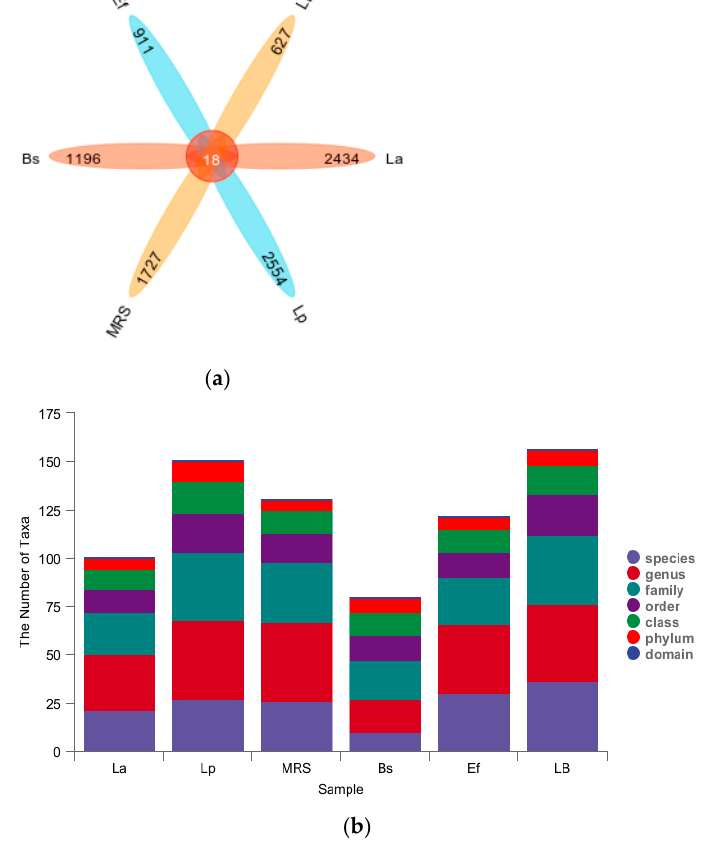
Figure 2. Classi fi cation unit number statistics: ( a ) petal map of taxonomic unit statistics (indicating the number of OTUs unique and common to each of the six groups Lp, La, MRS, Bs, Ef, and LB); ( b ) histogram of taxonomic unit statistics (indicating the number of taxonomic units contained in each of the six groups Lp, La, MRS, Bs, Ef, and LB at the seven taxonomic levels of domain, phylum, order, family, genus, and species, respectively, with unclassified, uncultured, uncultivated, unknown, metagenome, etc., units